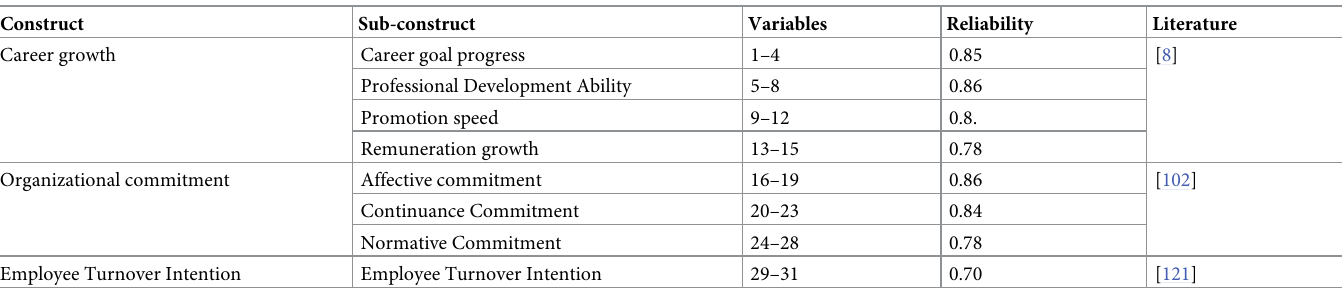
Table 2. Distribution of variables into constructs based on the